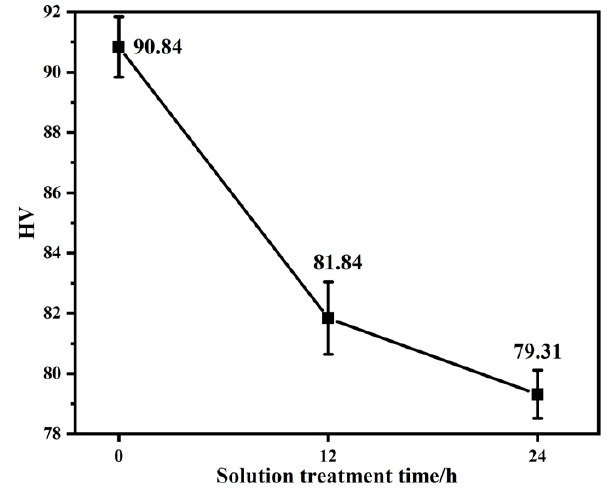
Figure 8. Hardness curves of alloys with different solution treatment times.